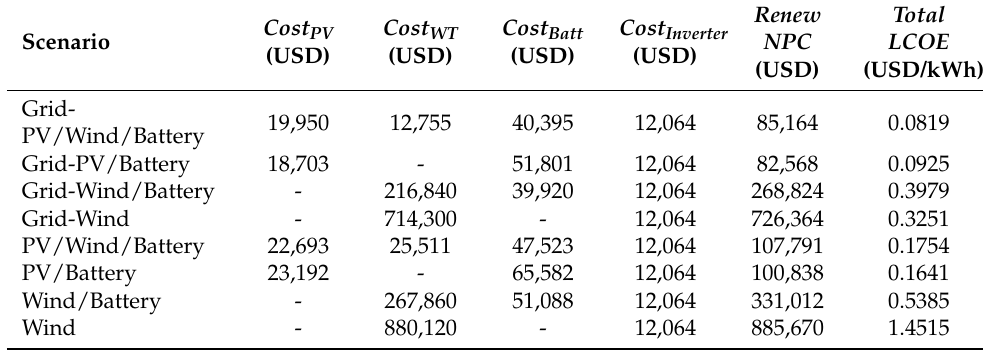
Table 9. Economic balance of the studied systems.